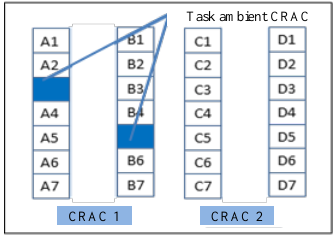
Table 1. Specifications of verification server room and CRAC.